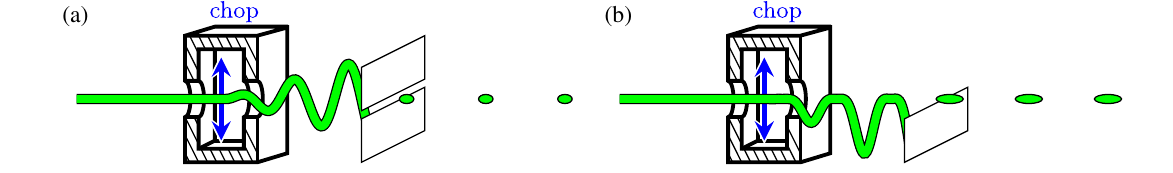
FIG. 4. (a) The principle of rf chopping. (b) The proposed method of chopping to increase the charge per pulse, using a fundamental mode, a higher harmonic mode and a constant magnetic field. The electron beam is shown in green and the force due to the oscillating magnetic field in